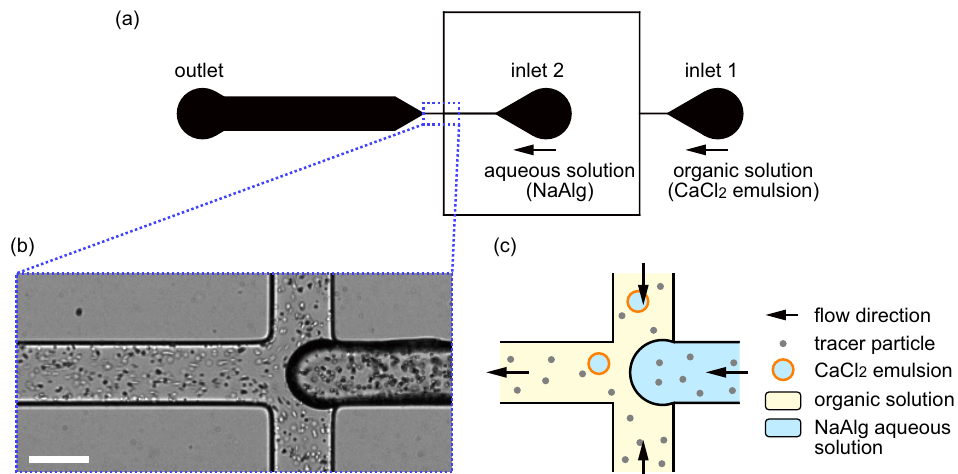
Figure 1. Experimental system for the production of droplets with an asymmetric shape. ( a ) Schematic diagram of the channel design. An organic solution containing CaCl 2 emulsions and an aqueous solution of NaAlg contact with each other at the junction indicated by the blue dashed rectangle. Both the channel height and width around the junction are 50 µ m. ( b ) Microscopic image of the junction. Scale bar, 50 µ m. ( c ) Schematic illustration of the flow at the